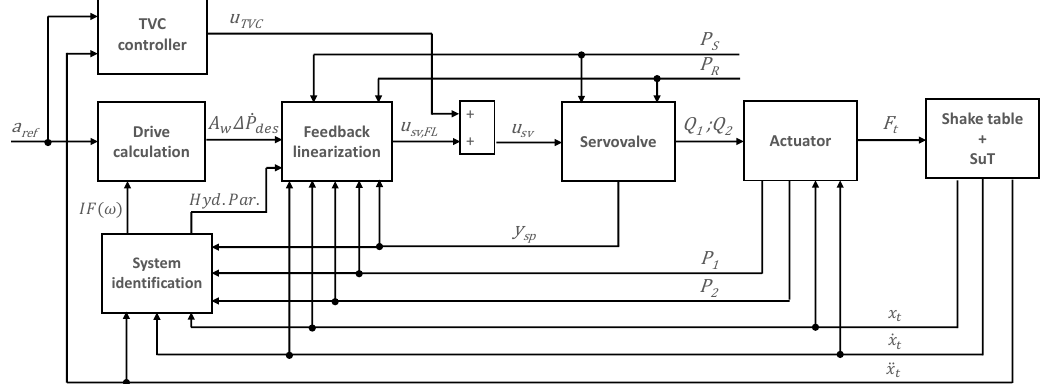
Figure 5. Control architecture block diagram.